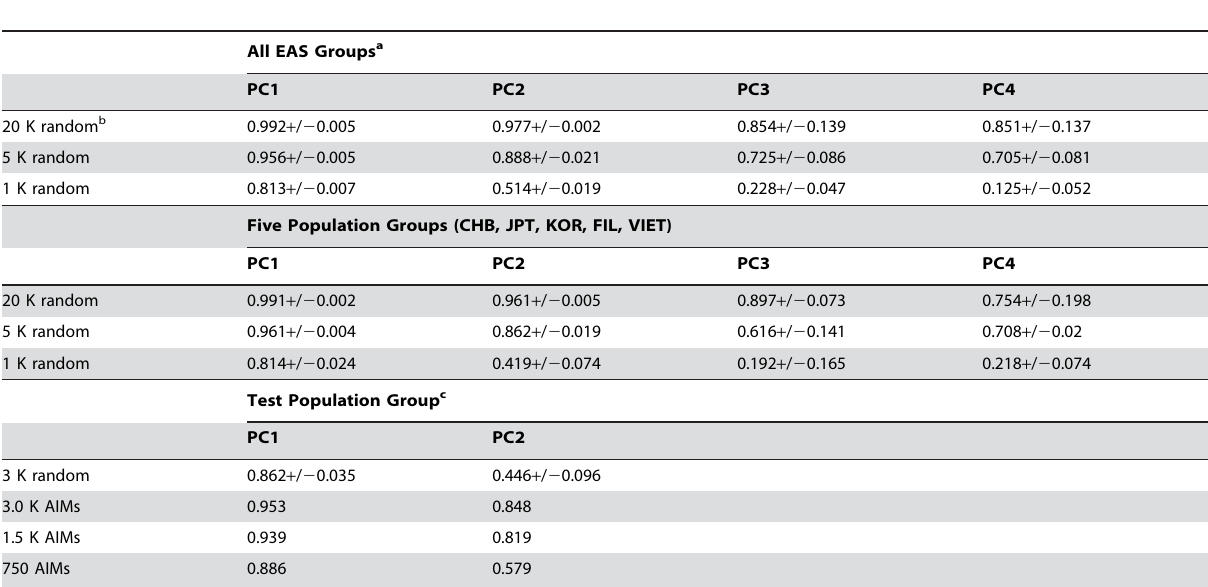
Table 3. Correlation of PCA Results using Random and Selected Sets with 200 K